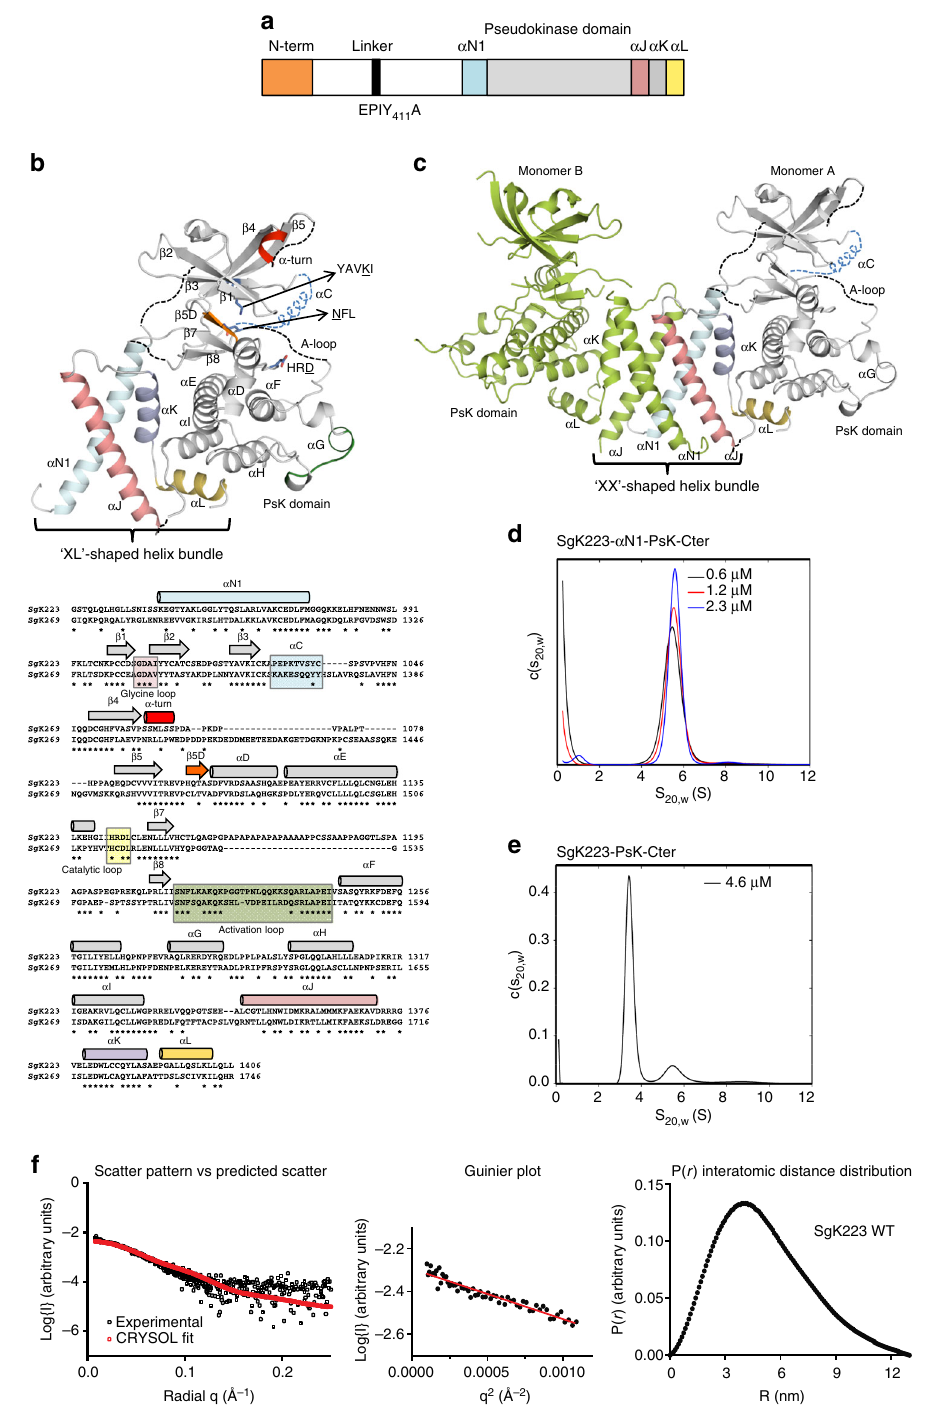
Fig. 1 Structure of SgK223- α N1-PsK-Cter. a Schematic representation of SgK223. Y411 is phosphorylated by Csk, and also serves as docking site for this kinase. b Structure of SgK223- α N1-PsK-Cter monomer (top) and sequence alignment of SgK223 and SgK269 and secondary structure elements as determined from the SgK223- α N1-PsK-Cter crystal structure (bottom). α N1, cyan; PsK domain, grey; α J, salmon; α K violet; α L yellow; catalytic residues are shown in sticks and underlined; α C is modelled in blue dashed lines. c Structure of SgK223- α N1-PK-Cter dimer. Monomer A colour coding as in b ; monomer B shown in green. d Continuous standardized sedimentation coef fi cient [ c ( s 20,w )] distributions for SgK223- α N1-PsK-Cter at concentrations of 0.6 μ M (black line), 1.2 μ M (red line) and 2.3 μ M (blue line). e c ( s 20,w ) distribution for SgK223-PsK-Cter at a concentration of 4.6 μ M. f Left: overlay of experimental scattering data (black circles) and scattering pro fi le calculated using CRYSOL (red). Middle: Guinier plot indicating that aggregates do not measurably contribute to the scattering pro fi le. Right: Interatomic distance distributions. See also Supplementary Fig.